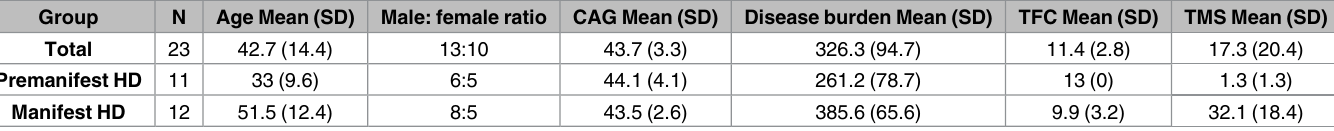
Table 1. Characteristics of the study